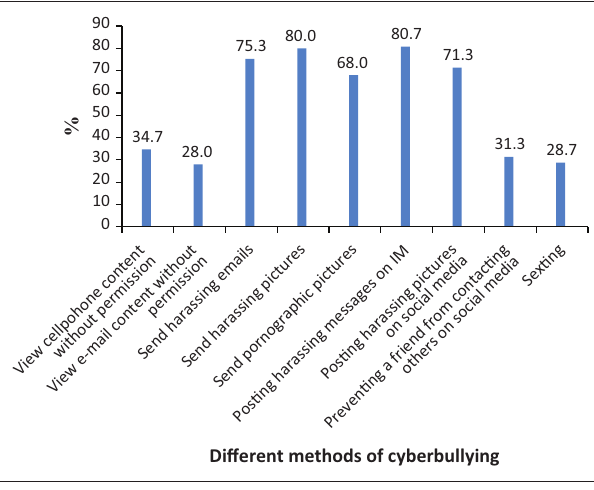
FIGURE 1: Methods that can be used to